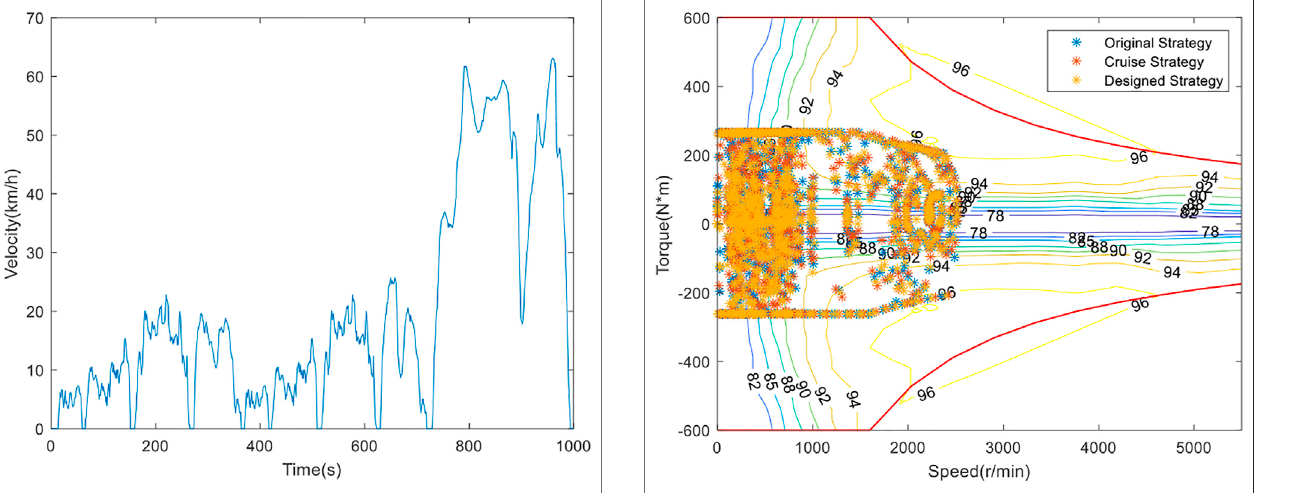
FIGURE 10 | Road spectrum diagram of vacuum vehicle.